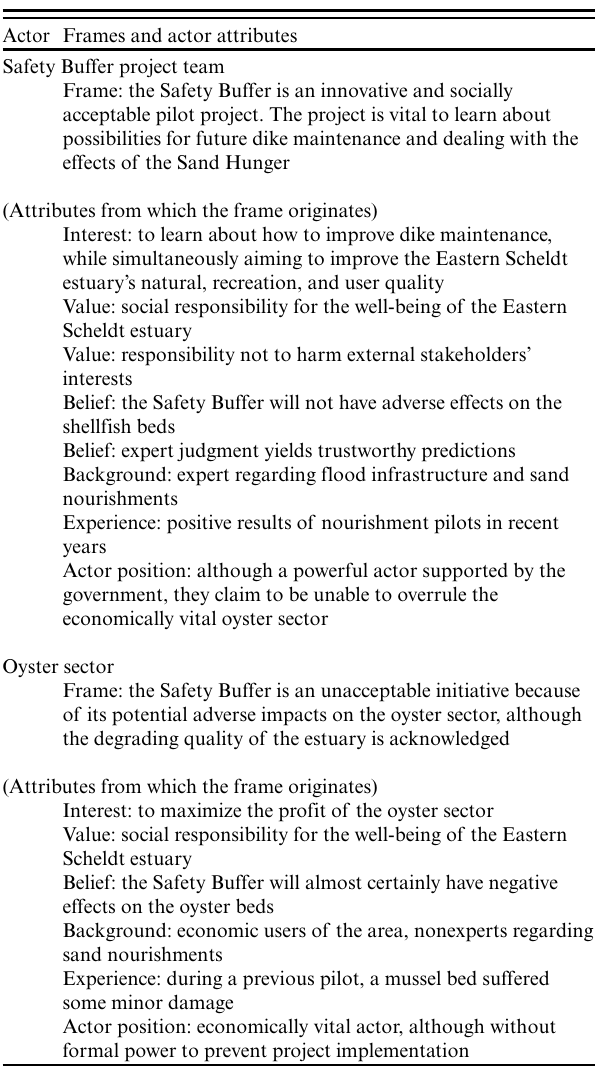
Table 5 . Safety Buffer Oyster Dam ambiguity 1: about the effects of the nourishment on oyster